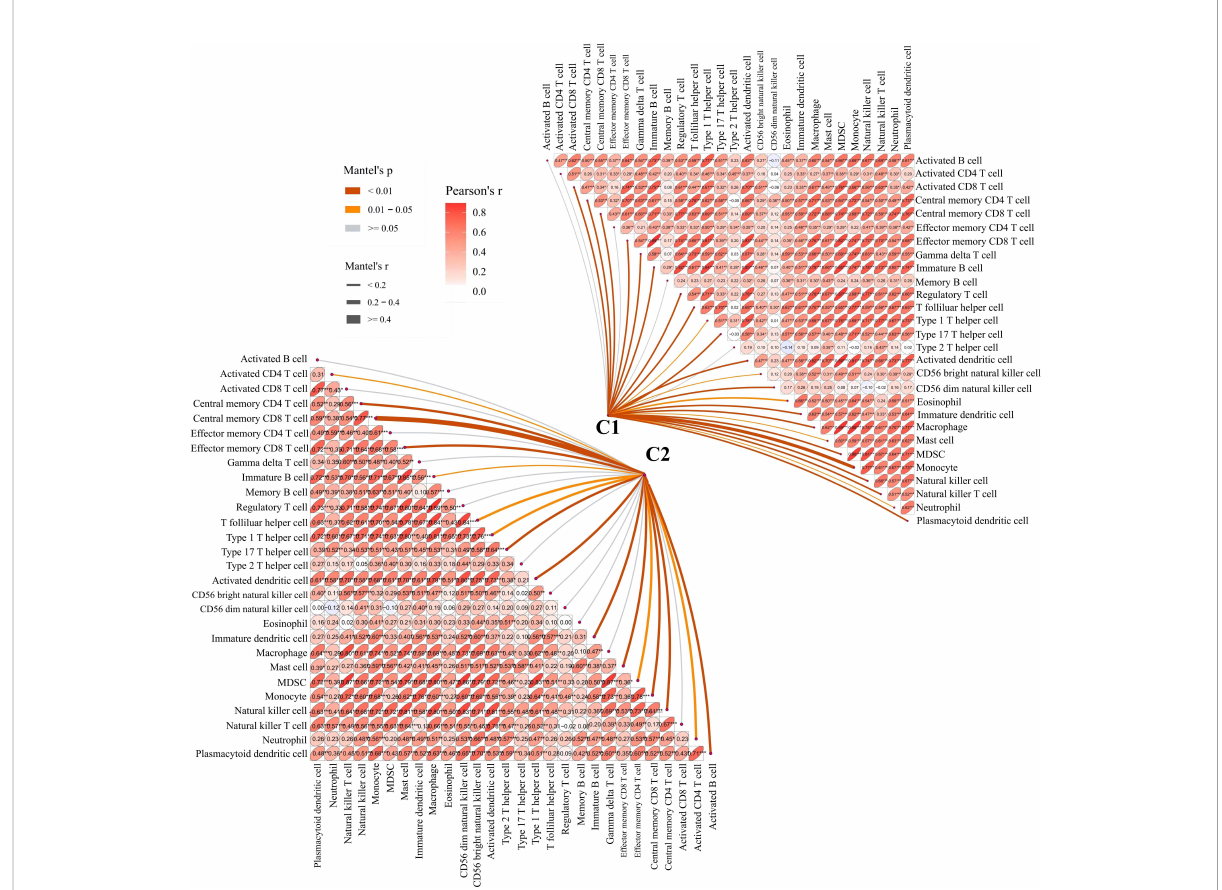
FIGURE 4 Correlation between C1 and C2 groups and 28 immune cells. The line width represents the r value of mentel; the line color represents the p value of mentel analysis results; the numbers in the ellipse represent Pearson ’ s coef fi